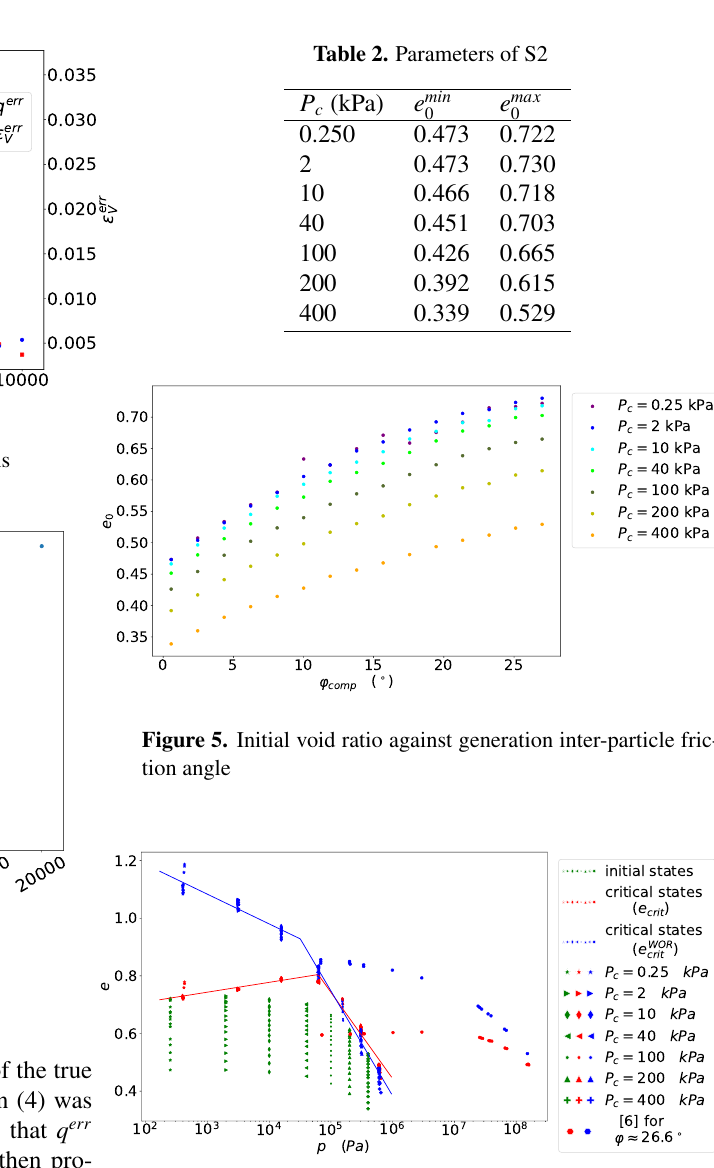
Figure 6. Critical state lines for all S2 simulations with rattlers (red symbols) and without (blue